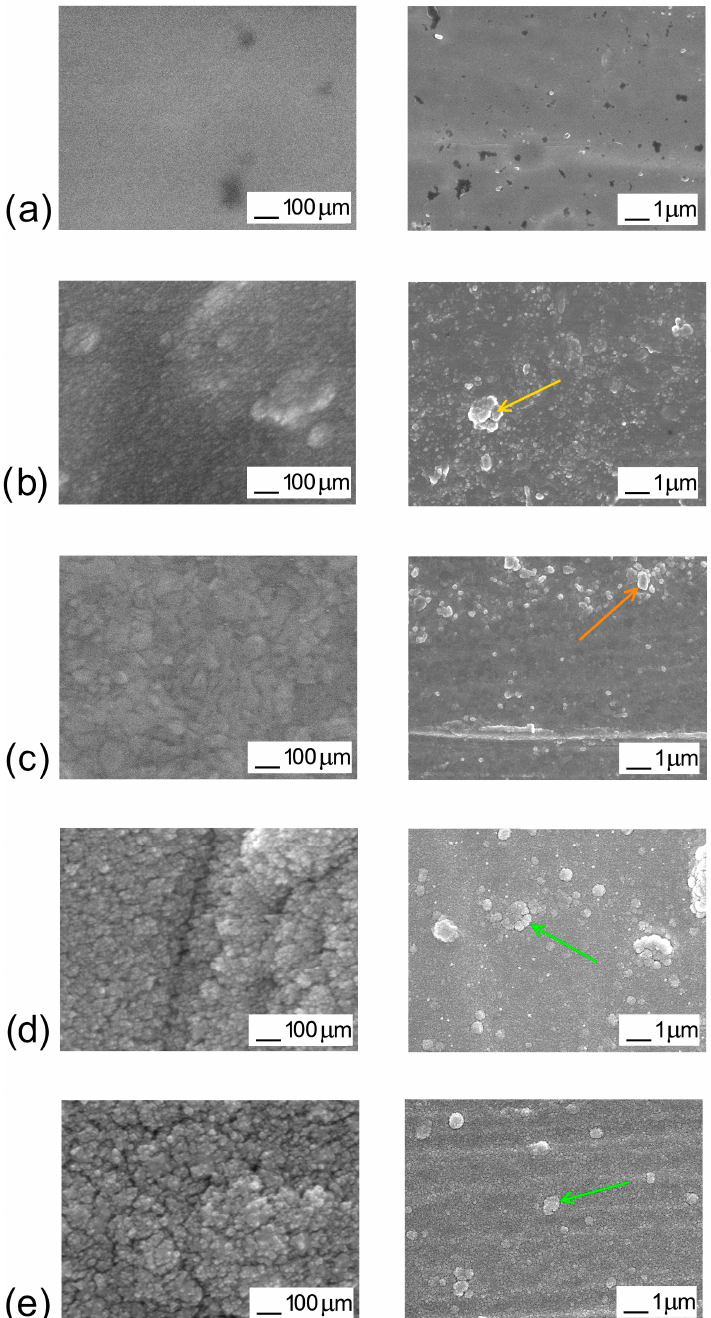
Figure 6. SEM micrographs of the surfaces of TiNi substrates and those coated with noble metal films: ( a ) bare TiNi ( b ) Ir’/TiNi; ( c ) Au/TiNi; ( d ) Ir/Ir’/TiNi; ( e ) Ir/Au/TiNi. Magnification 100,000 times (left) and 10,000 times (right). The arrows indicate examples of primary surface agglomerates.